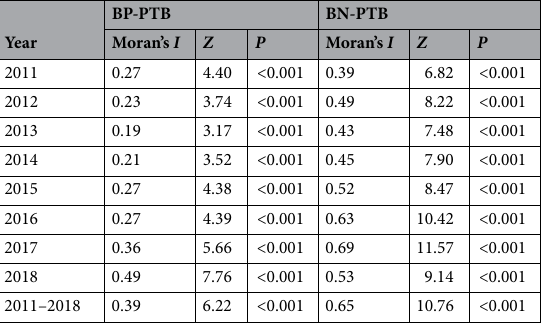
Table 2. Global spatial autocorrelations of the notified incidence rate of BP-PTB and BN-PTB in Shaanxi (2011–2018).